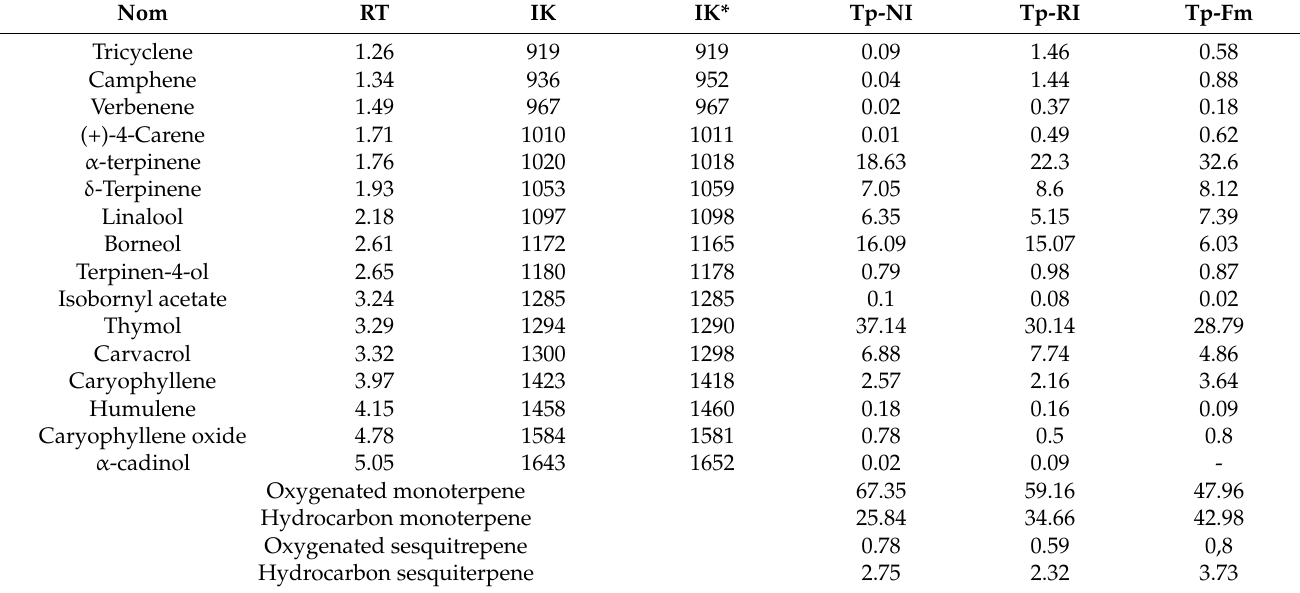
Table 2. Chemical composition of essential oil (in %) in inoculated and non-inoculated T. pallidus after 4 months of culture. RT—retention time; IK—Retention indices calculated relative to n-alkanes